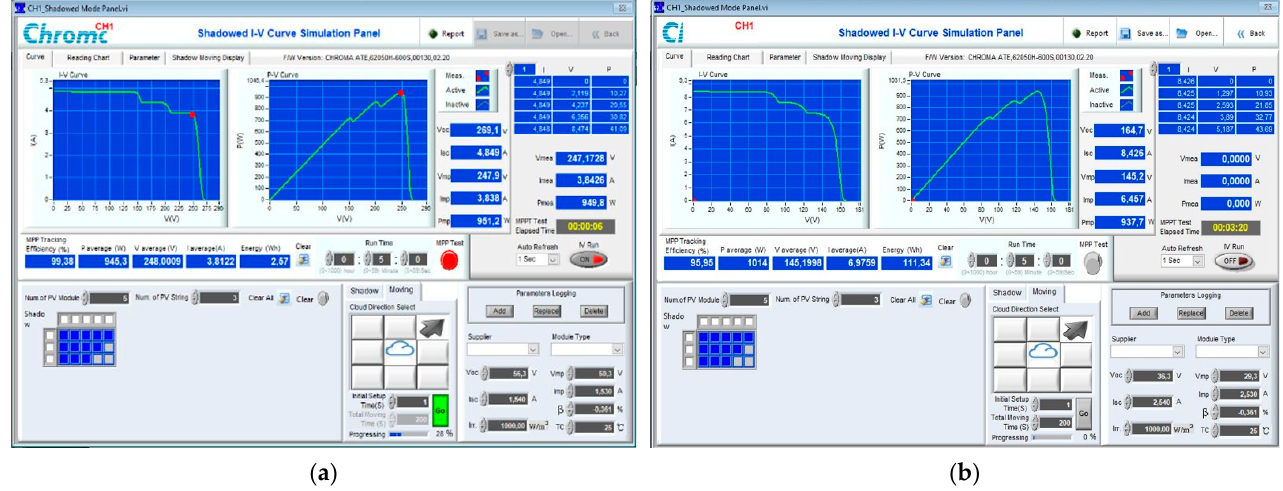
Figure 13. EKF MPPT test of two − phase IBC with 1 kW load: ( a ) partial shading and global MPPT tracking; ( b ) overall MPPT tracking efficiency.